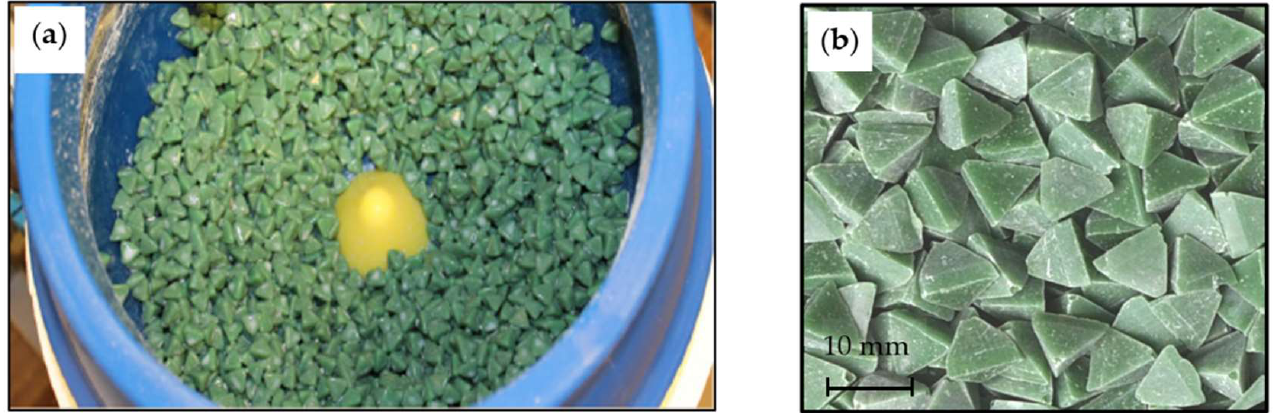
Figure 5. General view of the finishing media signed as 02PP10 in the working chamber of the EC6 smoothing machine ( a ) and an enlarged image of abrasive chips ( b ).